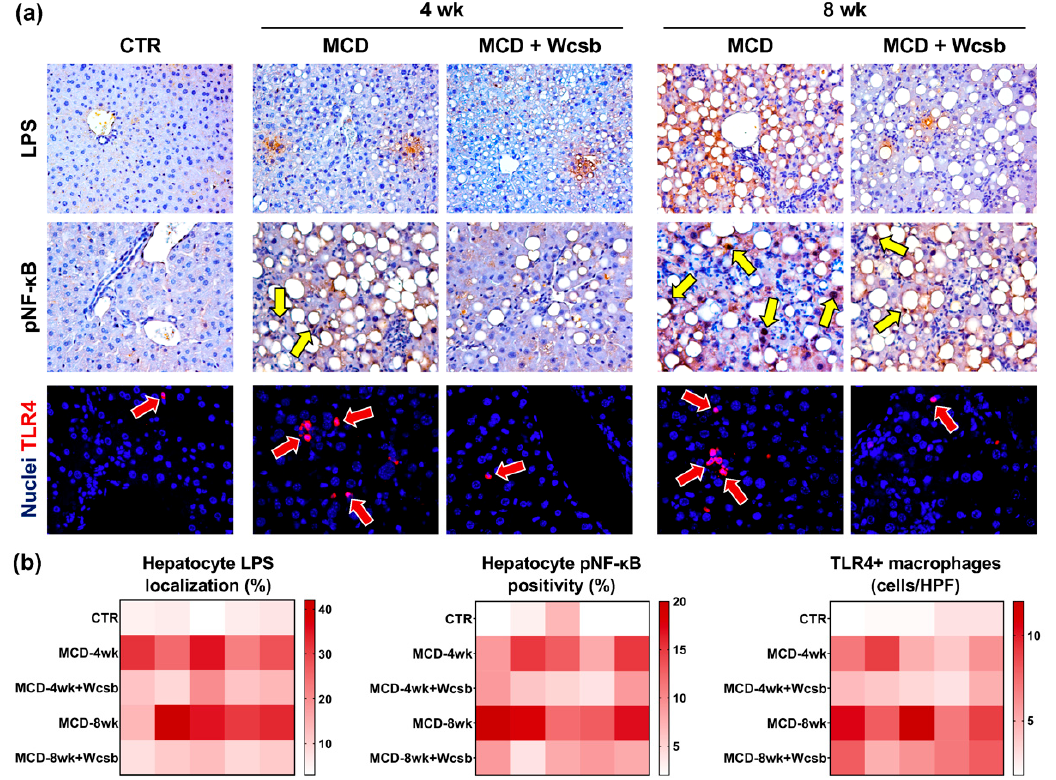
Figure 4. Lipopolysaccharide (LPS) hepatocyte localization and toll-like receptor (TLR)4 pathways in the livers of mice subjected to a methionine-choline-deficient (MCD) diet and treated with calcium-sulphate-bicarbonate water (W csb ). ( a ) Immunohistochemistry for LPS (upper panels), phospho-nuclear factor- κ B (pNF- κ B) (middle panels), and immunofluorescence for TLR4 (lower panels) in controls (CTR), and in MCD mouse livers, after four weeks (4wk) or eight weeks (8wk) of MCD diet administration, with or without W csb . W csb administration in MCD mice was associated with lower hepatocyte LPS localization, nuclear pNF- κ B positivity (yellow arrows) and a reduced number of infiltrating TLR4+ macrophages (red arrows). Original magnification: 10× (immunohistochemistry) and 20× (immunofluorescence). In immunofluorescence, nuclei are in blue. ( b ) Heat maps report data from all animals for the percentage of LPS+ and pNF- κ B+ hepatocytes, and for the number of TLR4+ macrophages. Each cell represents an individual animal.